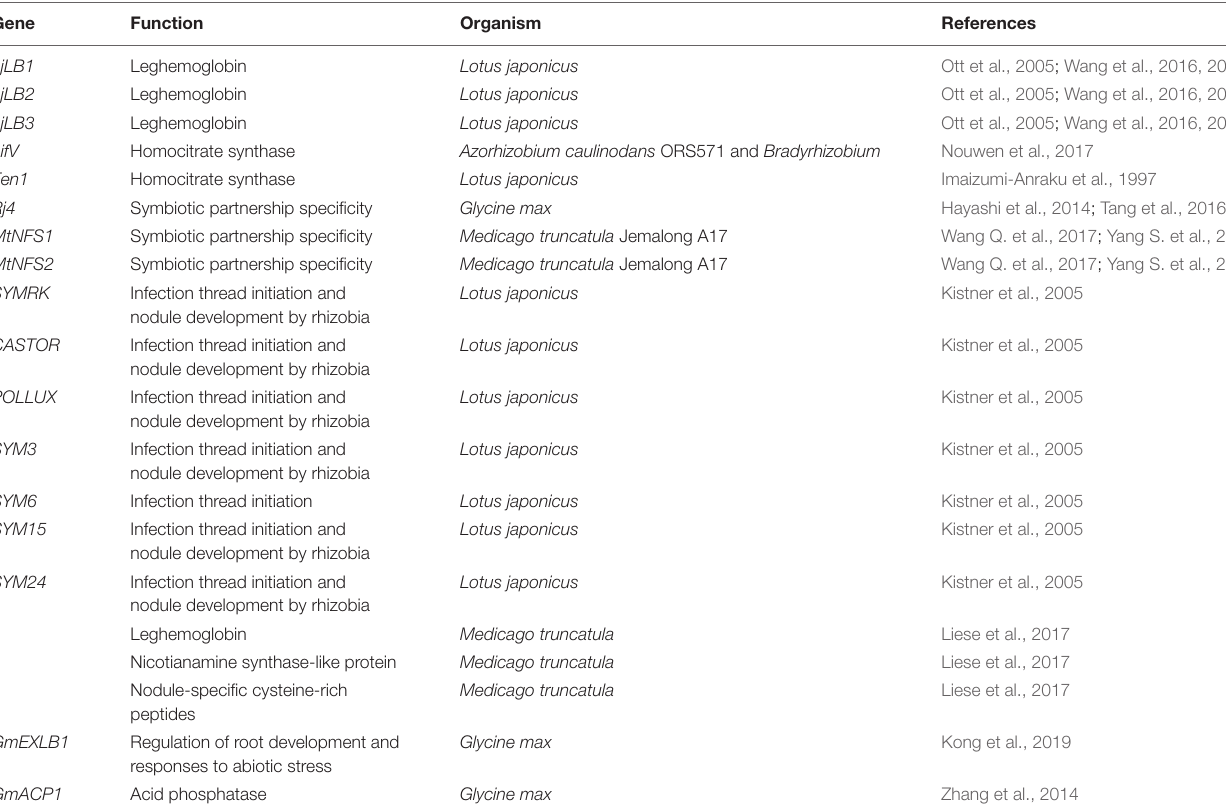
TABLE 1 | Functional genes involved in legume